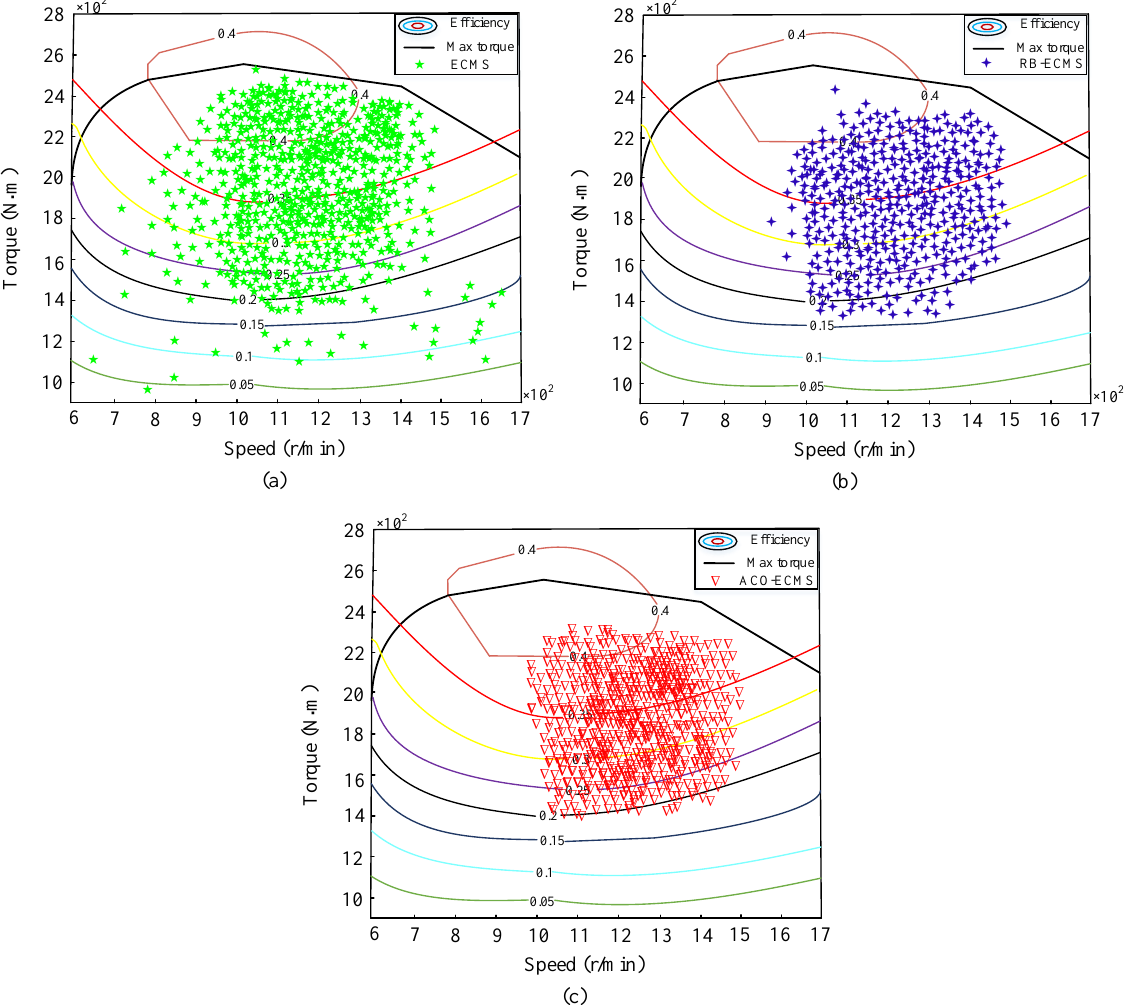
Figure 15. Comparison of three control strategies for diesel engine efficiency ( a ) ECMS. ( b ) RB-ECMS. ( c ) ACO-ECMS.